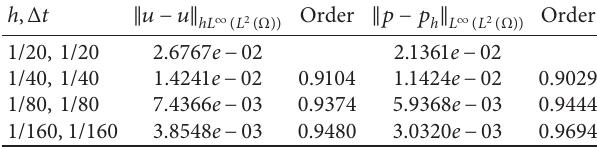
Table 1: Error results and convergence orders. h, Δ t